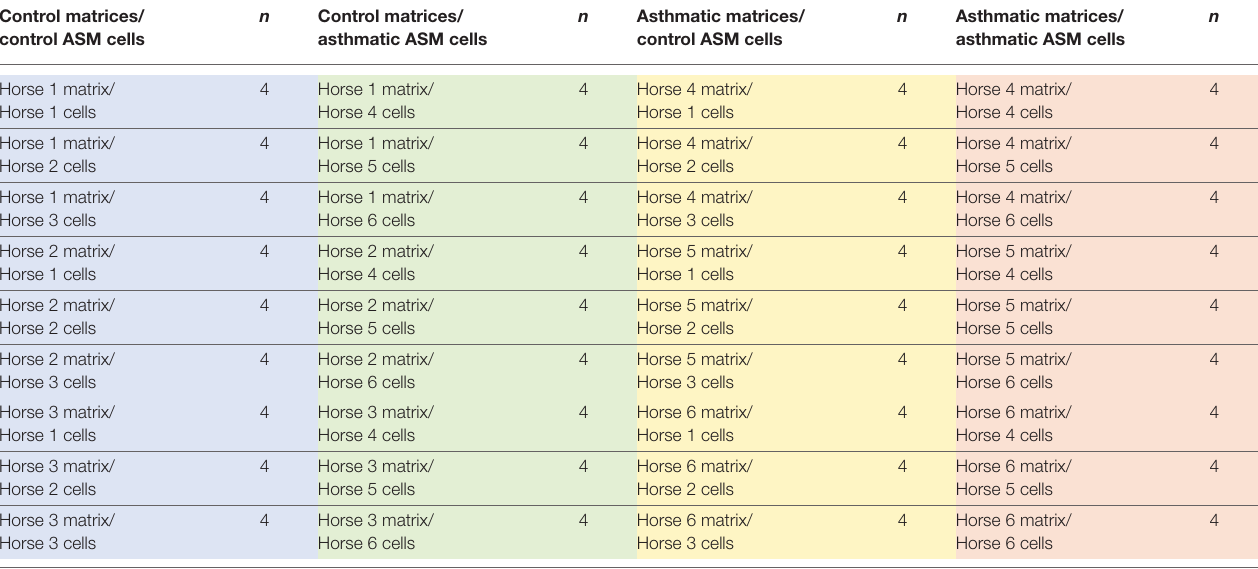
TABLE 1 | Decellularized biologic bronchial matrices from control ( n = 3) and asthmatic horses ( n = 3) were recellularized with primary bronchial airway smooth muscle (ASM) cells from the same control ( n = 3) and asthmatic horses ( n = 3). Control matrices/ control ASM